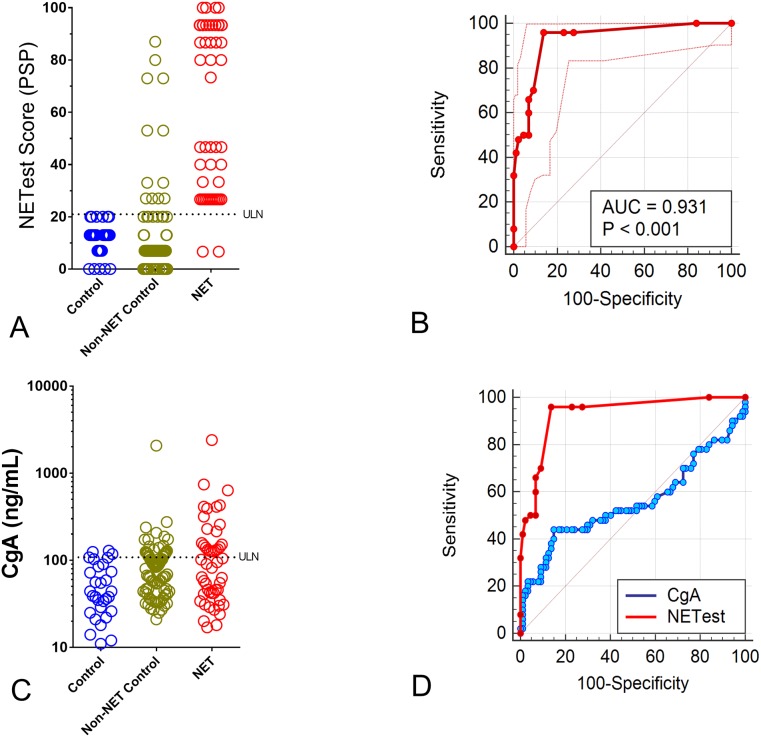
NETest scores and CgA levels in an independent validation cohort (Sample Set II, n = 167).4A. All 30 controls exhibited NETest scores ≤20. Twenty-eight (93%) of non-NET controls exhibited scores ≤20. Forty-eight (96%) of 50 NETs exhibited scores >20. 4B. The AUROC for differentiating NETs from non-NET controls was 0.93±0.02 (95%CI: 0.88–0.97), p<0.0001. 4C. Individual CgA measurements from the control, non-NET controls and NET samples using a standard CLIA ELISA approach. 4D. AUROC comparison between the NETest and CgA for differentiating NETs from non-NET controls. The difference in AUC was 0.38±0.06 (95%CI: 0.26–0.49). The z-statistic was 6.44, p<0.0001. ULN = upper limit of normal.